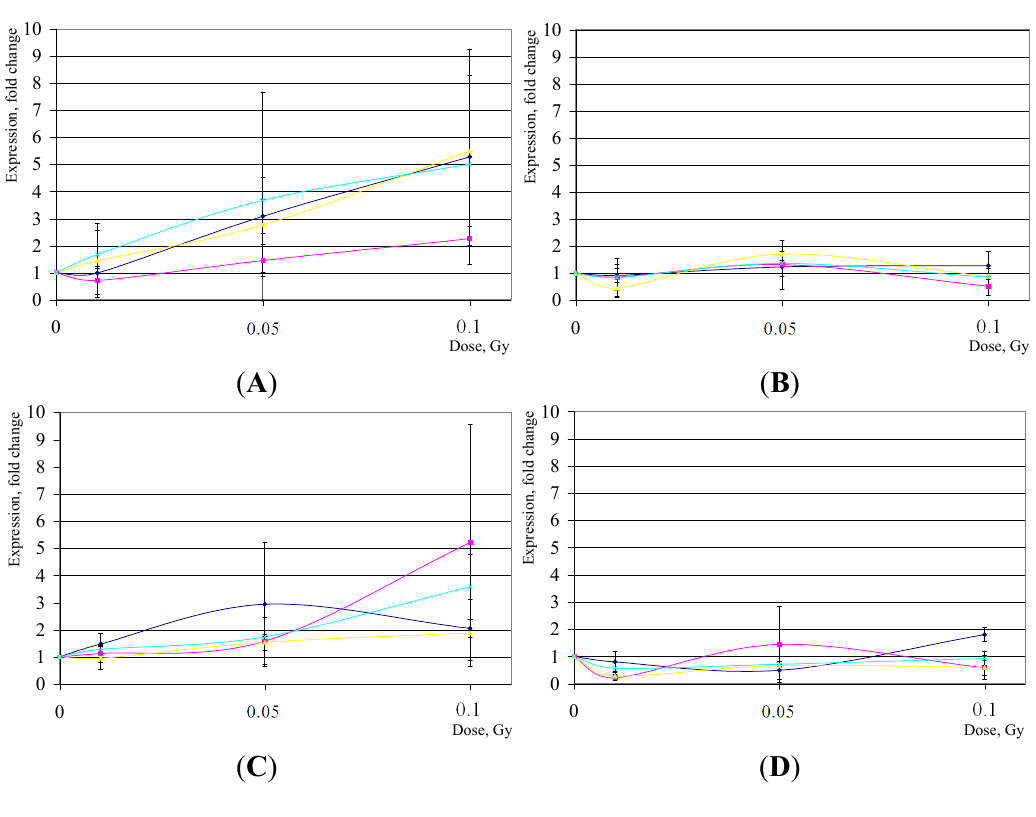
H14. ( A , C ), gene expression changes 2 h post-IR; ( B , D ), 16 h post-IR,